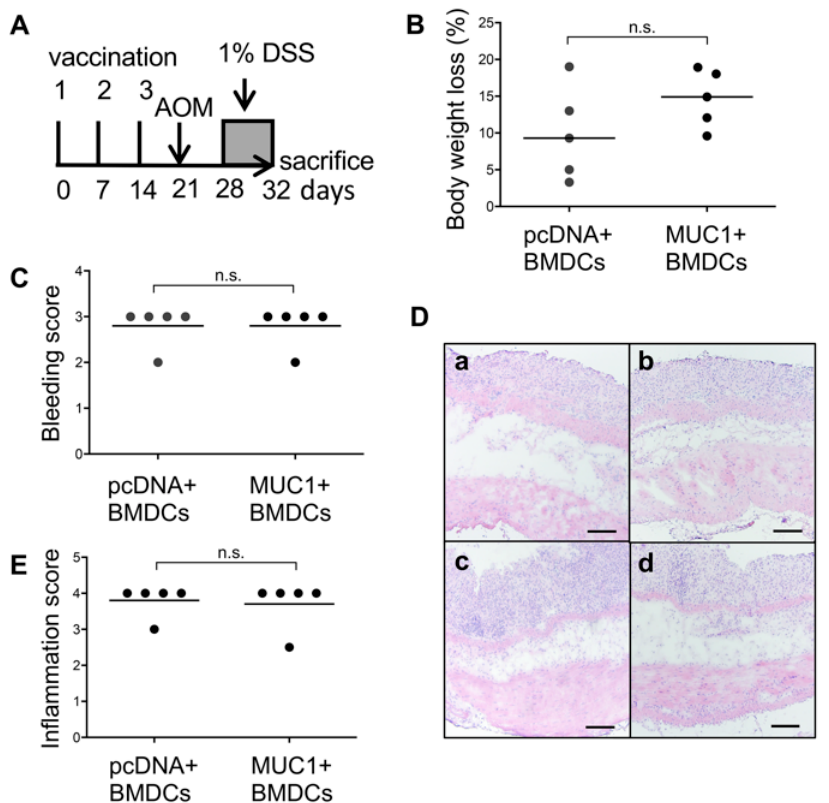
Figure 4. Effect of vaccination with MUC1 + BMDCs on the degree of colonic inflammation induced by azoxymethane-dextran sulfate sodium (AOM-DSS) treatment in MUC1.Tg mice. Colonic inflammation was evaluated in pcDNA + BMDCs and MUC1 + BMDCs vaccinated mice, after injection of AOM (10 mg/kg) and 5 days of 1% DSS administration. ( A ) Experimental setup. ( B ) Body weight loss. ( C ) Bleeding score. ( D ) Representative images of Hematoxylin/Eosin-stained cryosections of the colorectal (a,c) and anal (b,d) region in pcDNA + BMDCs (top) and MUC1 + BMDCs (bottom) vaccinated mice. Scale bar shows 100 μ m. ( E ) Inflammation score. In ( B , C ), and ( E ), each dot represents one mouse. The horizontal bar represents median. Mann–Whitney U test. n.s.: not significant.